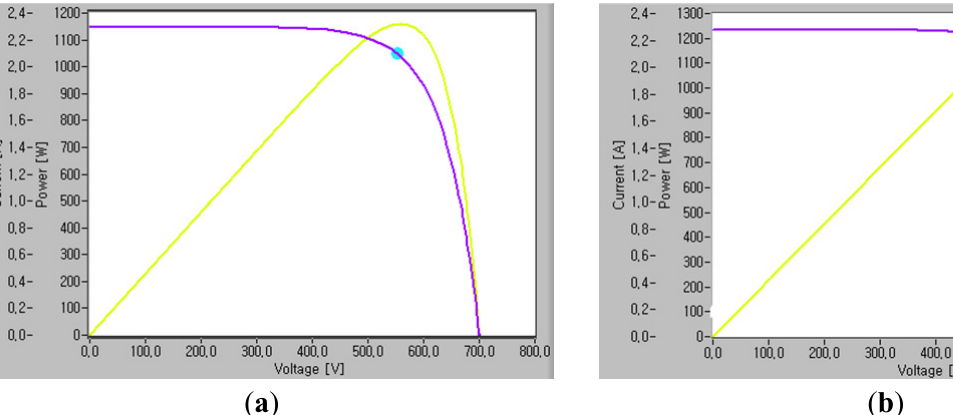
Figure 21. PV-curves of a PV simulator according to the temperature: ( a ) 30 °C and ( b ) 10